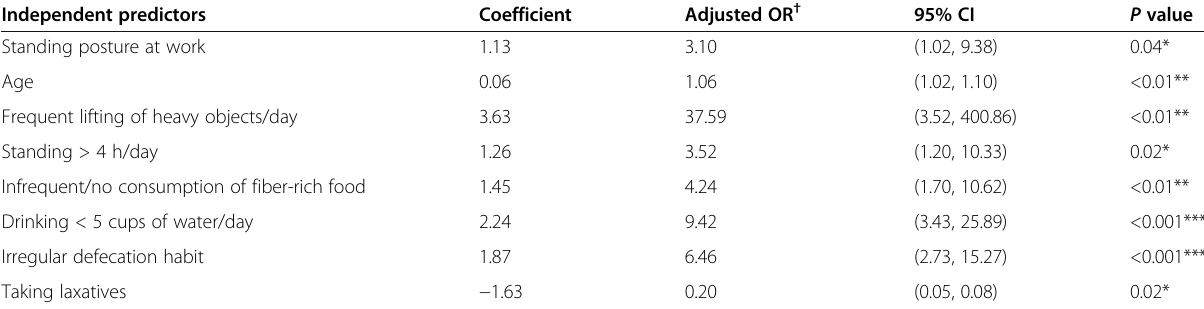
Table 5 Stepwise logistic regression analysis of the independent predictors of lower limb varicose veins (LLVV) among ever employed participants ( n =